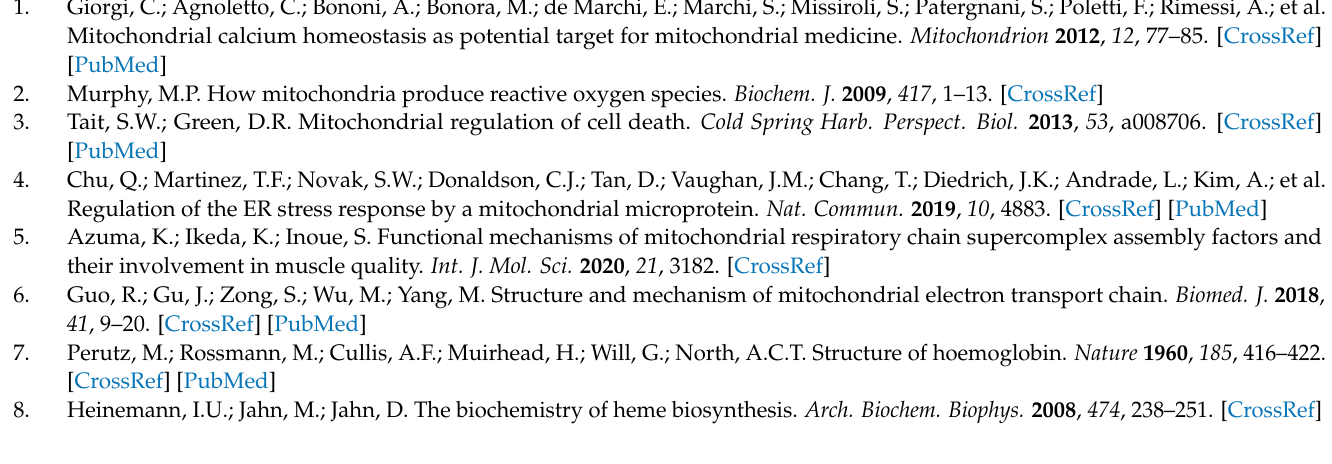
muscle tissue network (D) for upregulated proteins in the icefish, Figure S2: Highly connected protein nodes for RMM PPI using CentiScaPe, Cytoscape plugin, Figure S3: Highly connected protein nodes for WMM PPI, Figure S4: Top modules obtained from the PPI network using Cytoscape’s plugin MCODE for Red muscle tissue network (C) and white muscle tissue network (D) for upregulated proteins in the icefish, Figure S5: Highly connected protein nodes for RMM PPI, Figure S6: Highly connected protein nodes for WMM PPI; Table S1: Proteins higher in abundance in N. rossii (RMM), Table S2: Proteins lower in abundance in N. rossii (RMM), Table S3: Proteins higher in abundance in C. rastrospinosus (RMM), Table S4: Proteins lower in abundance in C. rastrospinosus (RMM), Table S5: Proteins more in abundance in C. gunnari (RMM), Table S6: Proteins less in abundance in C. gunnari (RMM), Table S7: Proteins higher in abundance in N. rossii (WMM), Table S8: Proteins lower in abundance in N. rossii (WMM), Table S9: Proteins higher in abundance in C. rastrospinosus (WMM), Table S10: Proteins lower in abundance in C. rastrospinosus (WMM), Table S11: Proteins more in abundance in C. gunnari (WMM), Table S12: Proteins less in abundance in C. gunnari